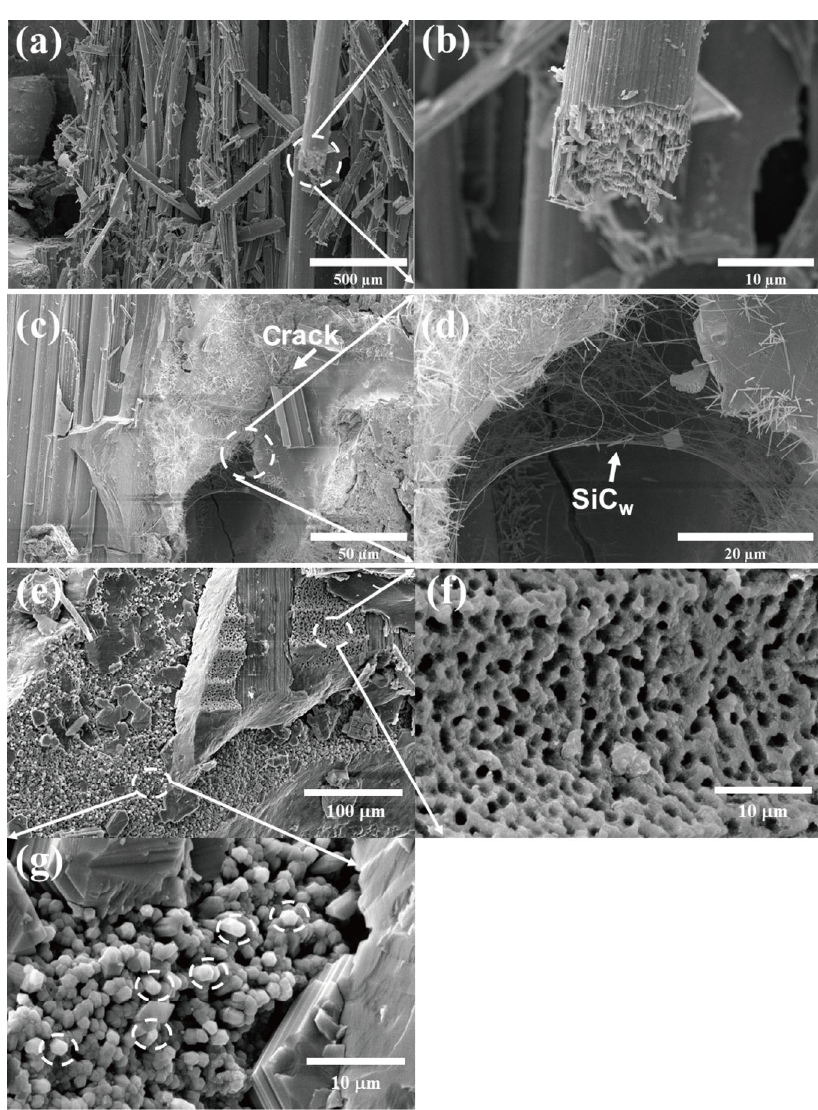
Fig. 14 Microstructures of fractured fibers and SiC w